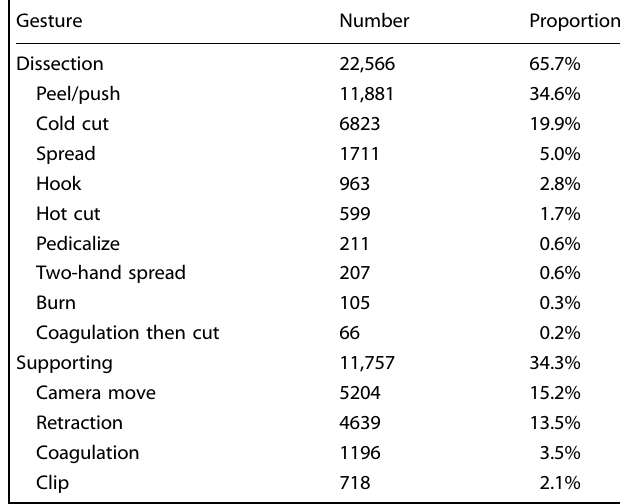
Table 2. Breakdown of different gestures used in the nerve- sparing